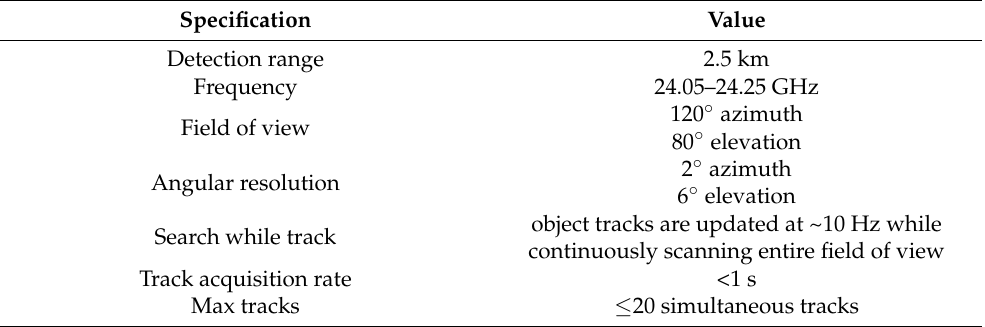
Table 4. Echodyne Counter-Drone Radar specifications.